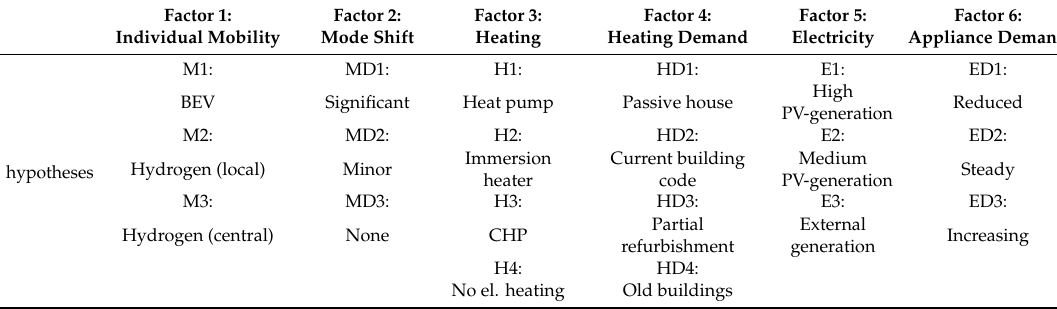
Table 1. Morphological box of the residential energy